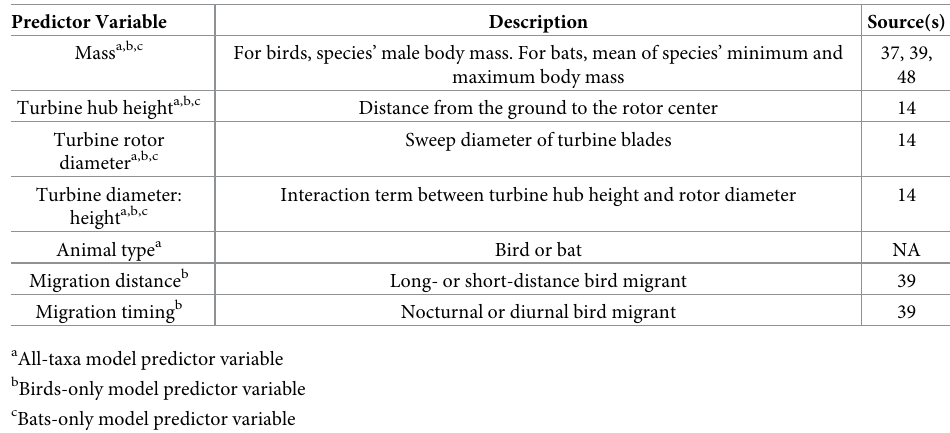
Table 1. Predictor variables used in generalized linear mixed models of bird and bat fall